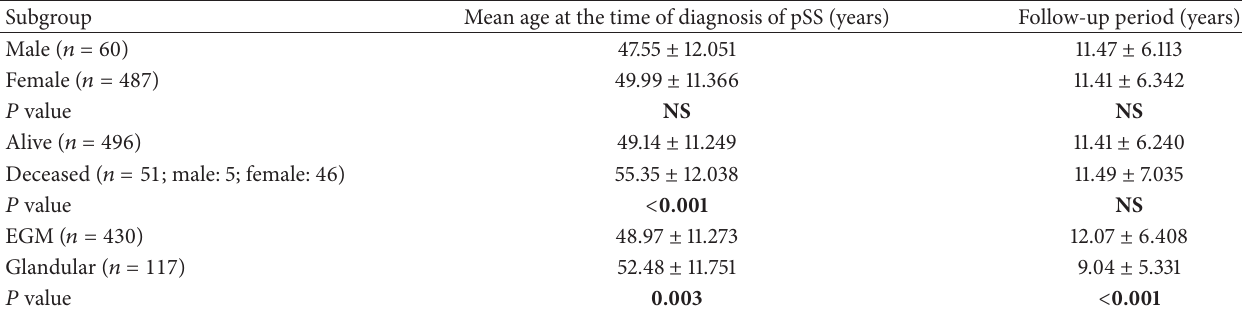
Table 1: The mean age of patients determined at the time of diagnosis and the average follow-up period.